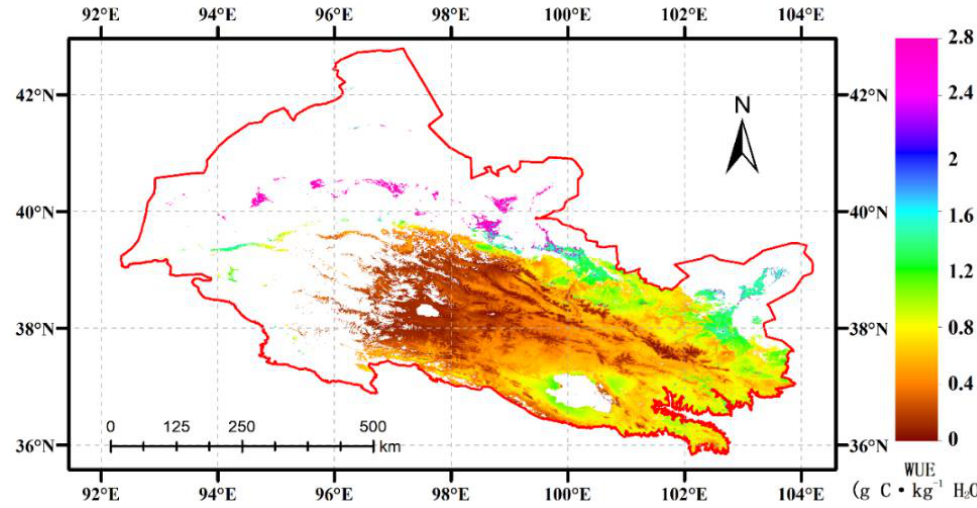
Figure 5. Spatial variation of WUE in the study area. The average annual WUE was overlaid with a vegetation-type map to obtain the WUE characteristics for each vegetation type within the study area. During 2002–2021, the average WUE of the seven vegetation types ranged from 0.2 to 1.15 gC kg − 1 H 2 O (Figure 6), with the highest WUE (1.15 gC kg − 1 H 2 O) for cropland, followed by broadleaved and coniferous forests with 0.90 and 0.75 gC kg − 1 H 2 O, respectively. Grassland, shrubs, meadows, and alpine vegetation followed in that order. Overall, the WUE of woodlands was significantly higher than that of shrubs and herbaceous plants, except for cropland affected by human activities.